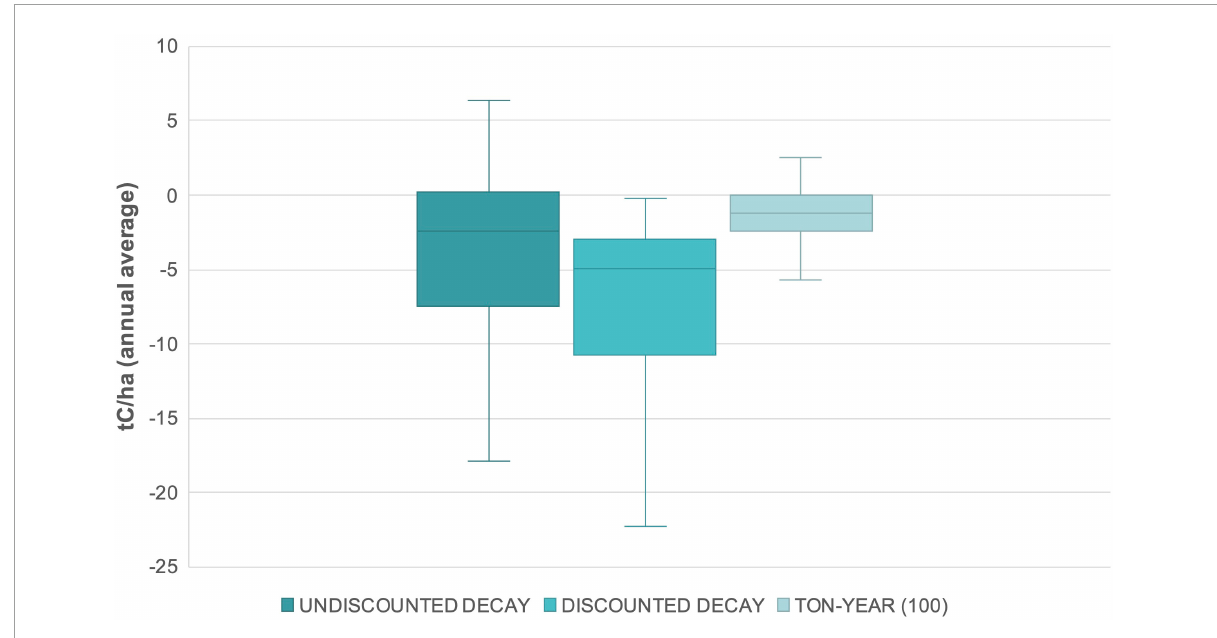
FIGURE2 Comparison of accounting approaches across project scenarios, showing average annual net sequestration by accounting approach, including all forest types, project lengths, and project baseline scenarios (e.g., reforestation vs. conversion). Ton-year results reflect a 100-year time horizon. Negative values represent net sequestration relative to a baseline, immediate-harvest scenario.